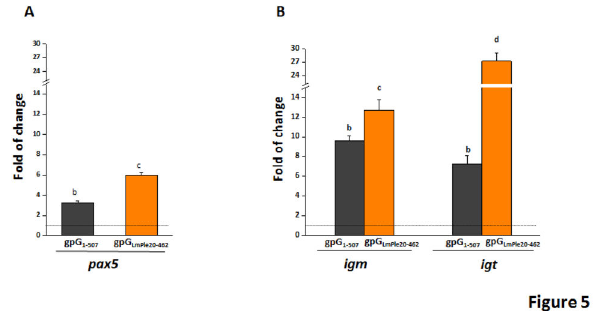
(black bars) or pAE6- 1-507